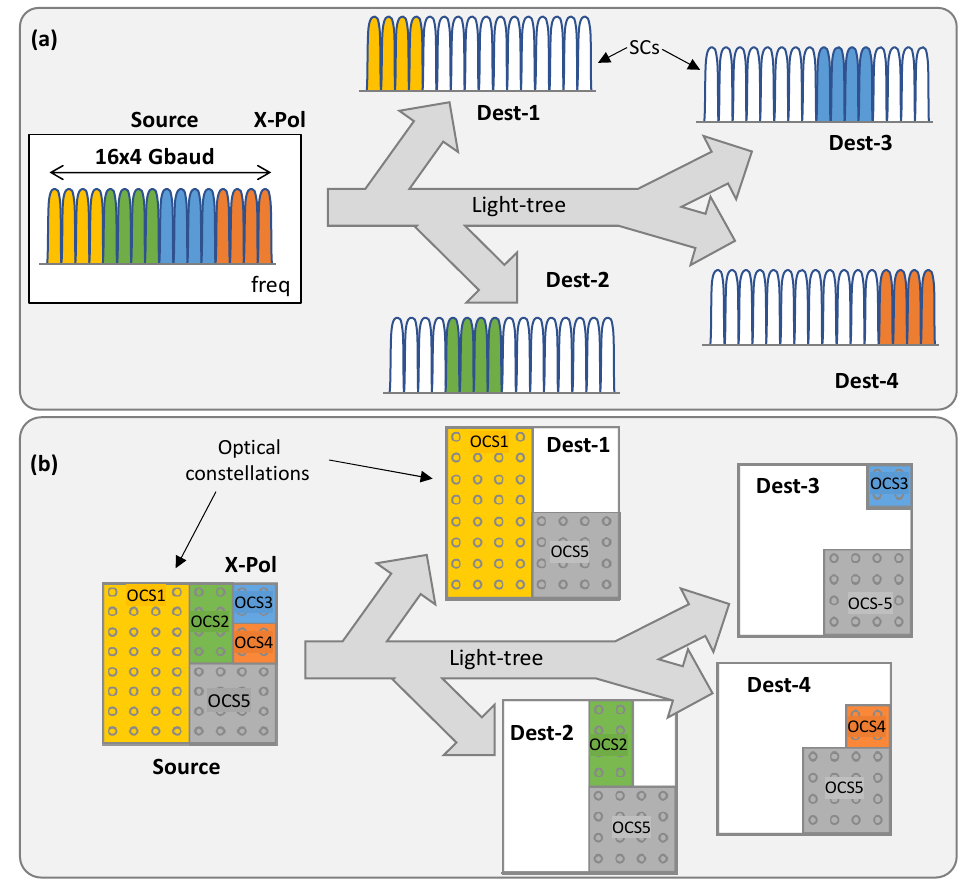
Figure 2. Application of DSCM ( a ) and OCS ( b ) for optical P2MP (updated from